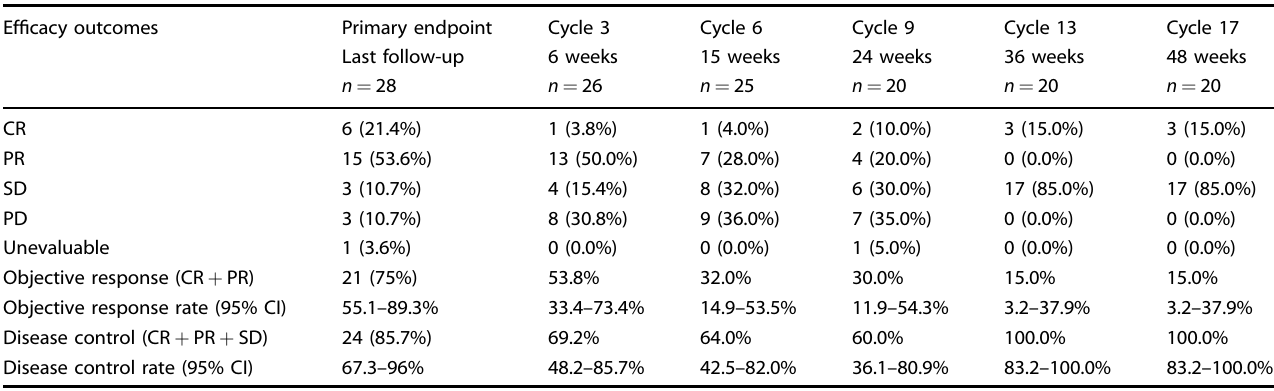
Table 2. Ef fi cacy evaluation of sintilimab during the whole trial